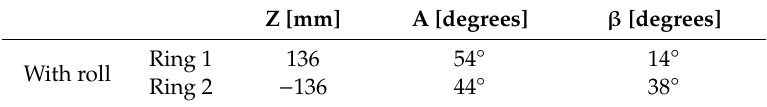
Table 7. Cylindrical coordinates of the camera positions on the two circular arrays.